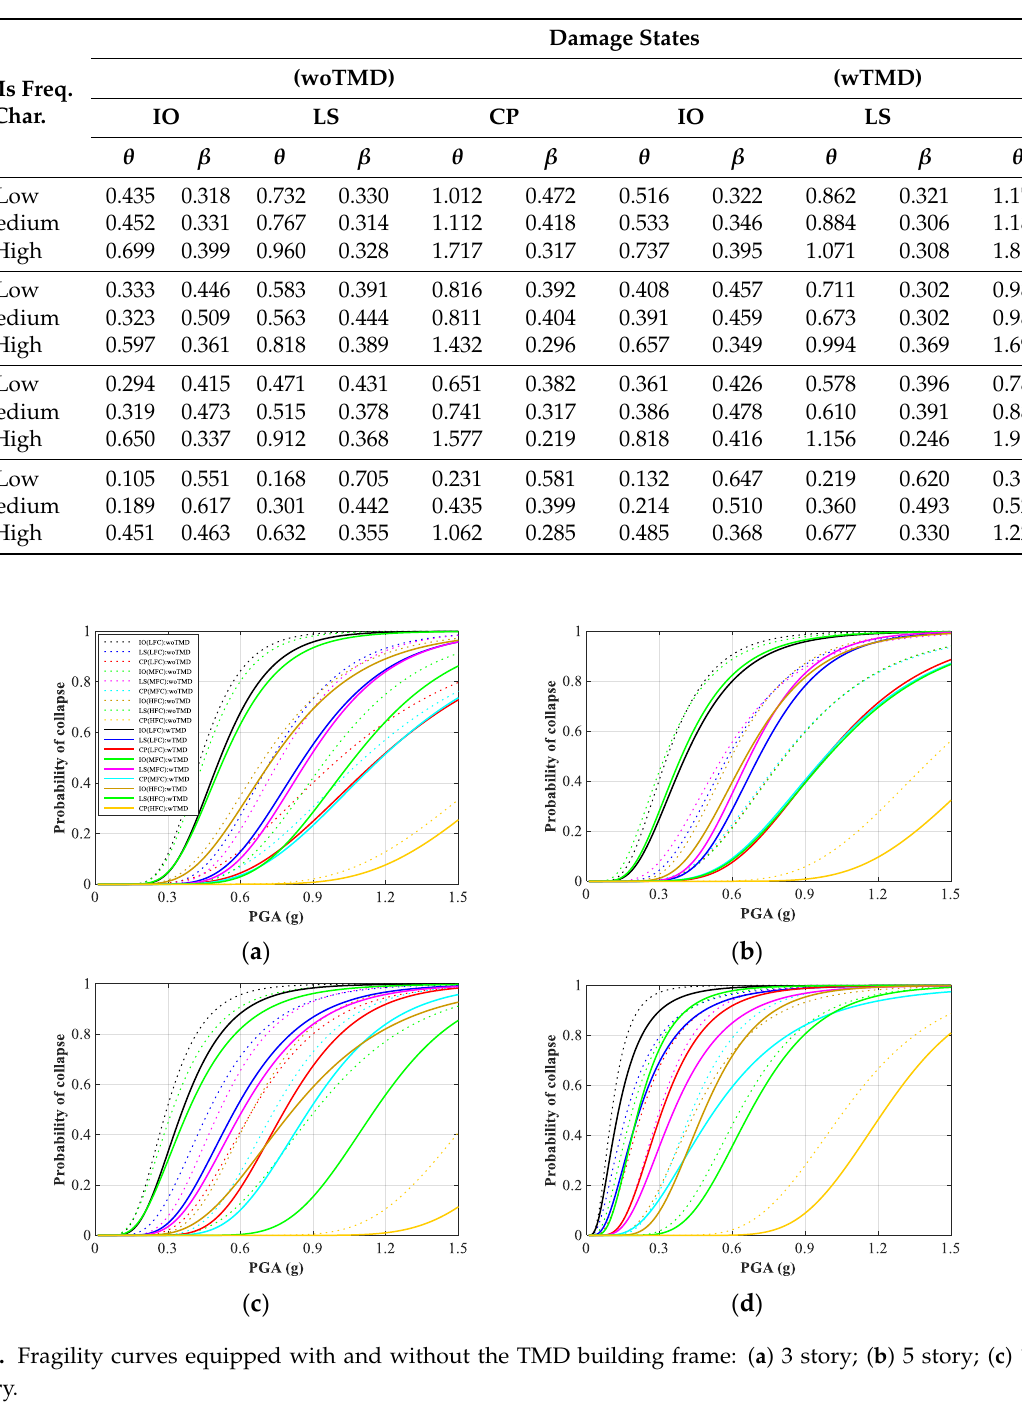
Table 4. Dynamic characteristics of the building frames.